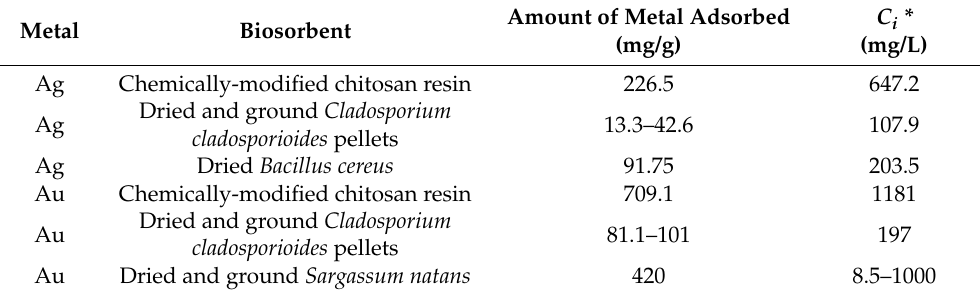
Table 1. Recovery of Ag and Au by several biosorbents. Modified from Soundararajan et al. [19] and Legorreta-Castañeda